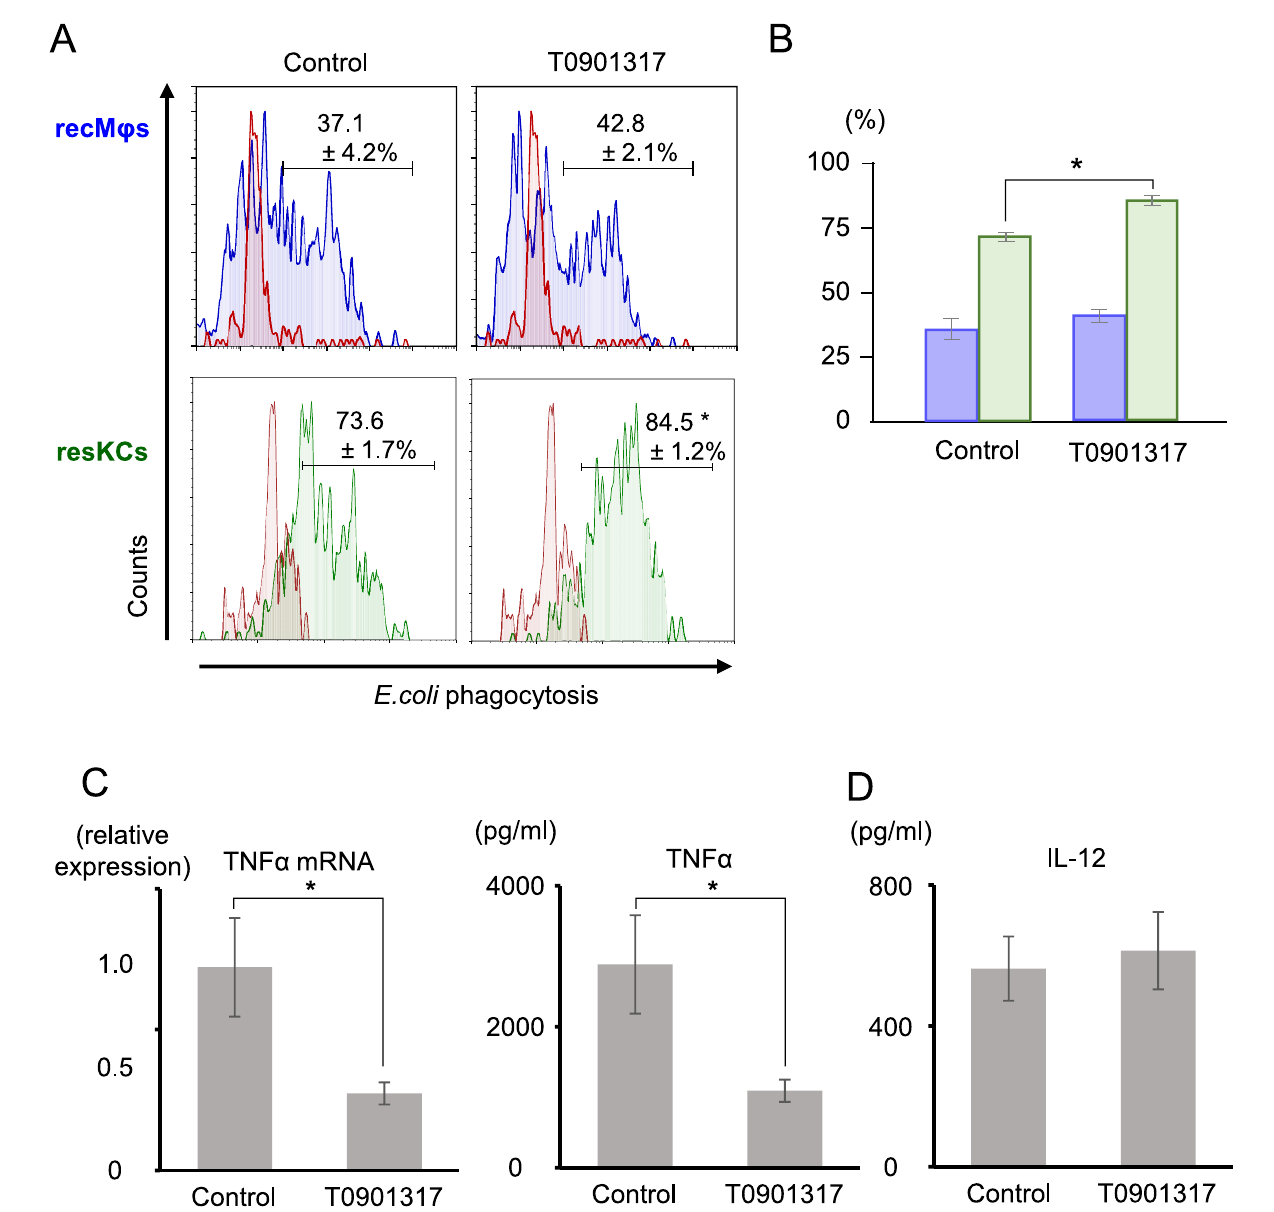
Fig 3. The increased in vitro phagocytic activity of resKCs and recM φ s against FITC- E . coli and the decreased TNF- α production by LPS- stimulated liver MNCs following pre-treatment with a synthetic LXR ligand (T0901317). (A) The phagocytic activity of recM φ s (upper panels, blue line) and resKCs (lower panels, green line) against E . coli . Negative controls were incubated with E . coli for 1 h on ice (red line). (B) Bar graph of the in vitro phagocytic activities of recM φ s (blue columns) and resKCs (green columns) in control and T0901317-treated MNCs (n = 12 in each group). (C) The in vitro TNF- α production by MNCs with or without T0901317 pre-treatment. Adherent cells were obtained after incubation with LPS for 45 minutes, mRNA was isolated, and the relative expression TNF mRNA was compared between the two groups (left panel, n = 5 in each group). After incubation with LPS for 6 h, culture supernatant was collected, and TNF- α concentration was measured and compared (left panel, n = 14 in each group). (D) IL-12 production by liver MNCs stimulated with LPS for 12 h with or without T0901317 pre-treatment (n = 9 in each group). Data are presented as the mean ± SE ( � p < 0.05, unpaired Student’s t